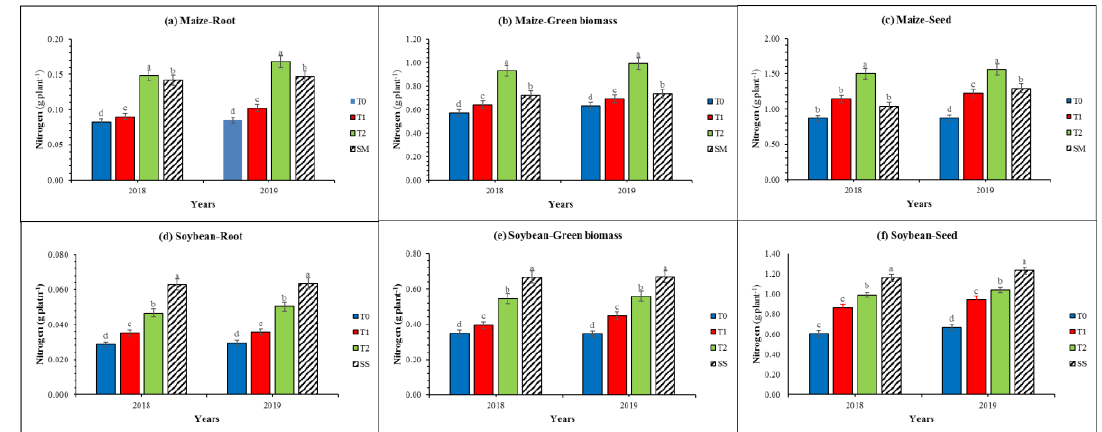
Figure 4. Root, green biomass and grain nitrogen content of maize ( a – c ) and soybeans ( d – f ) as a ff ected by di ff erent potassium treatments in the maize–soybean intercropping system (MSI) from 2018 to 2019 growing season. The T 0 , T 1 and T 2 represent the no potassium treatment, 40:30 kg ha − 1 and 80:60 kg ha − 1 , respectively, in MSI. The SS and SM refer to sole cropping system of soybeans and maize, respectively. Means are averaged over three replicates ± standard error. Means do not share the same letters in the column di ff er significantly at p ≤ 0.05.